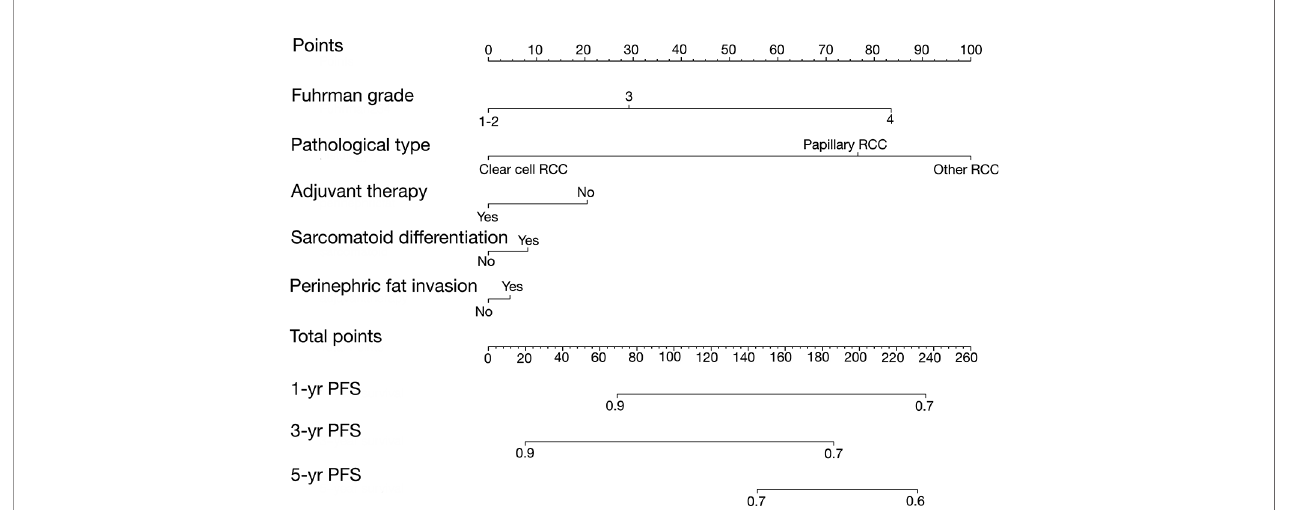
FIGURE 2 | The Peking University nomogram (PKUN) model predicting 1-year, 3-year, and 5-year